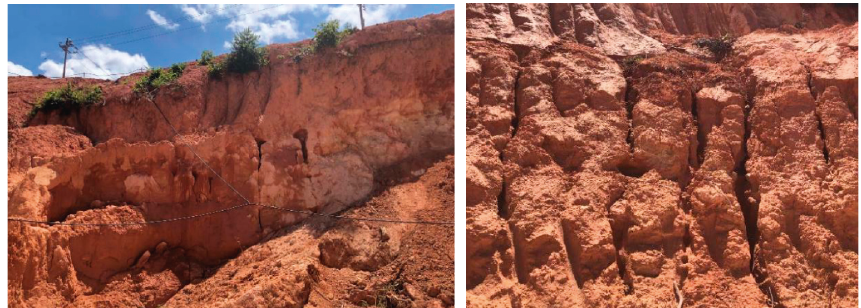
Figure 1: Granite residual soil in Youxi, Fujian